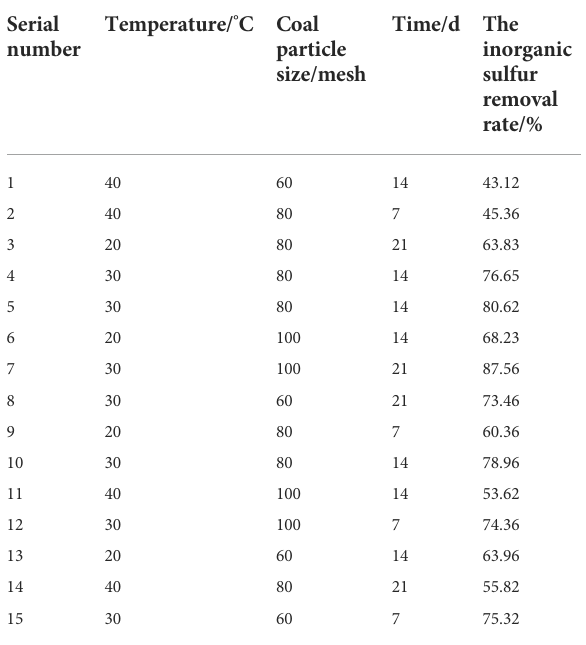
TABLE 7 Response surface test